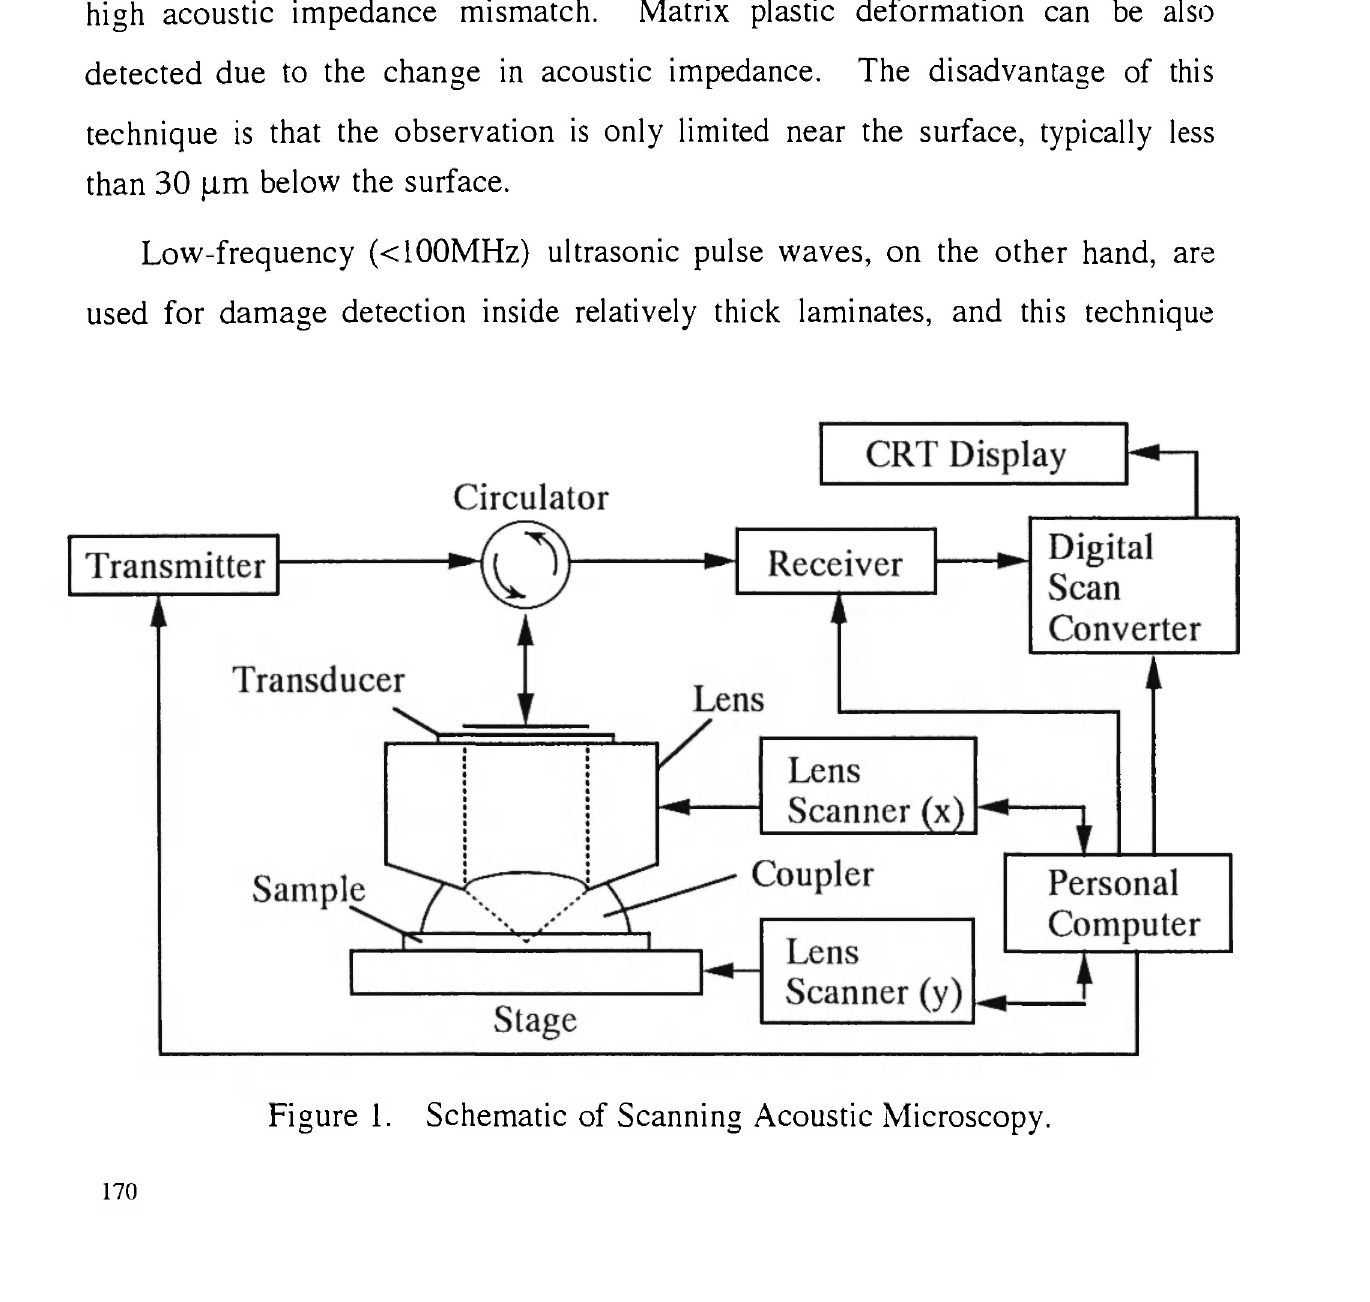
Figure 1. Schematic of Scanning Acoustic